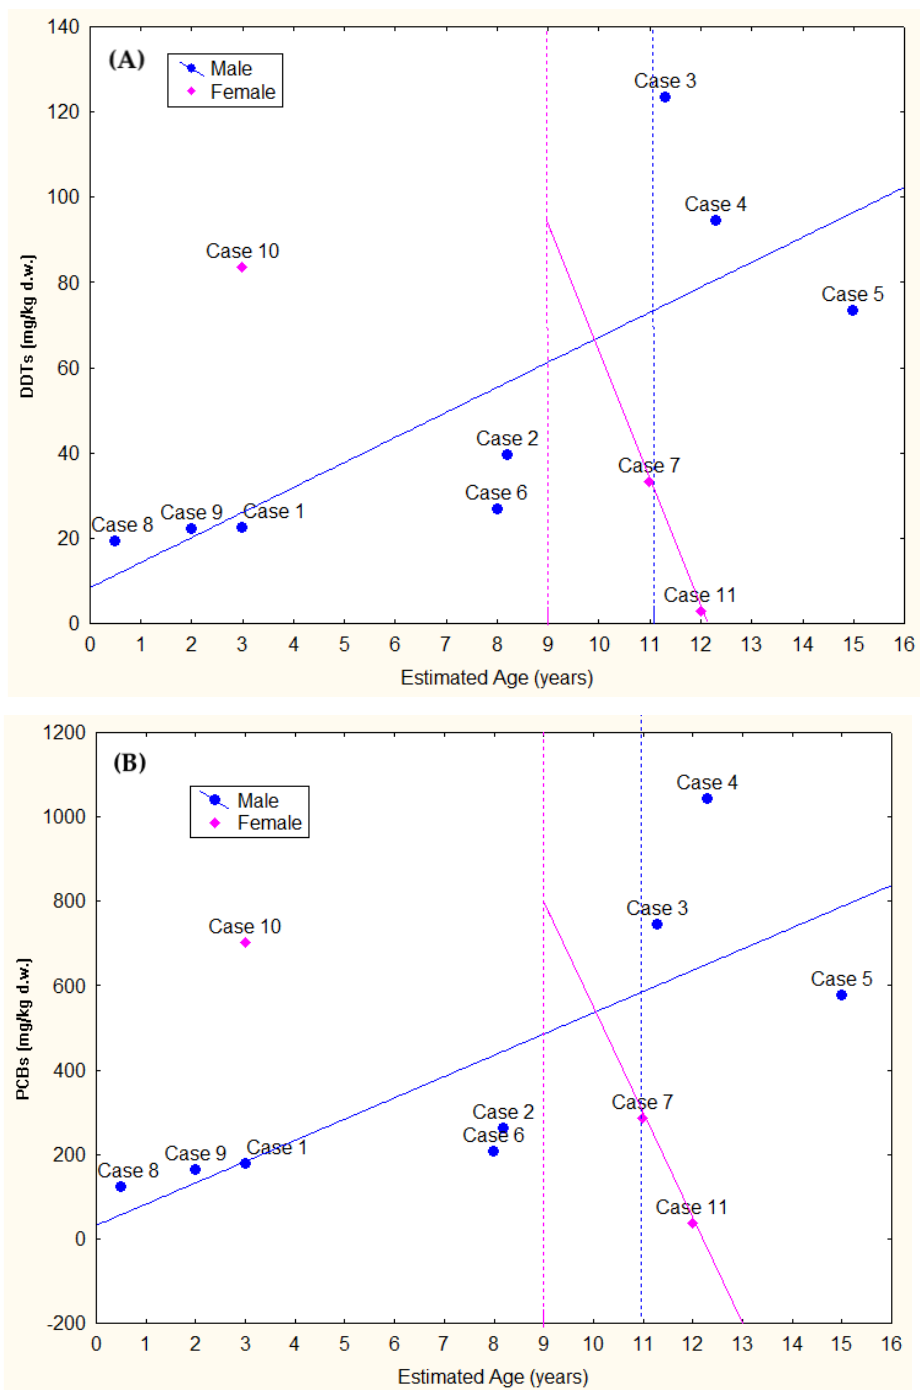
Figure 3. ( A , B ) Plotting of DDT ( A ) and PCB ( B ) levels in common bottlenose dolphins studied in relation to age estimated in relation to length. The pink dotted line indicates the age of sexual maturity for females (9 years) and blue for males (11 years). The blue continuous line represents the linear regression in males; the pink line shows the female trend after sexual maturity.